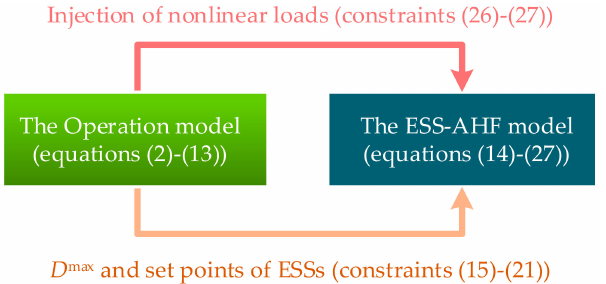
Figure 5. The ESS-AHF model as a sequential model after the operation